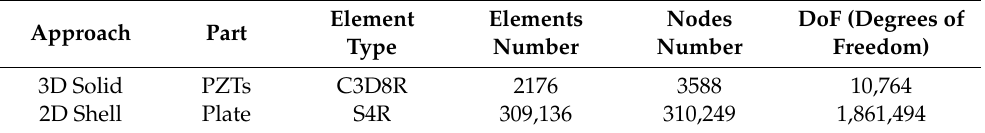
Table 2. FE modelling details for the flat